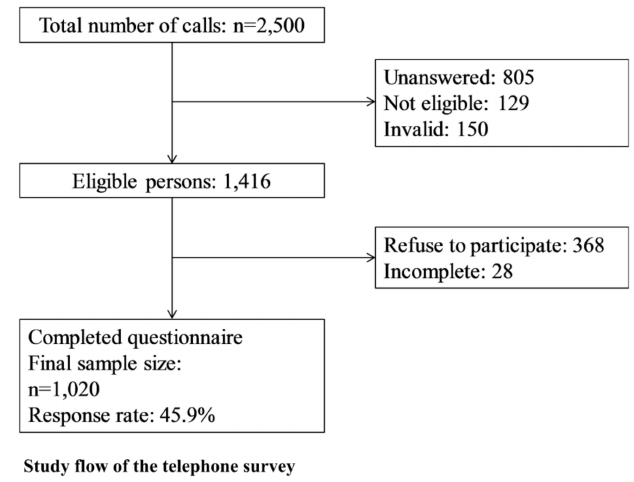
Figure 1. Study flow of the telephone